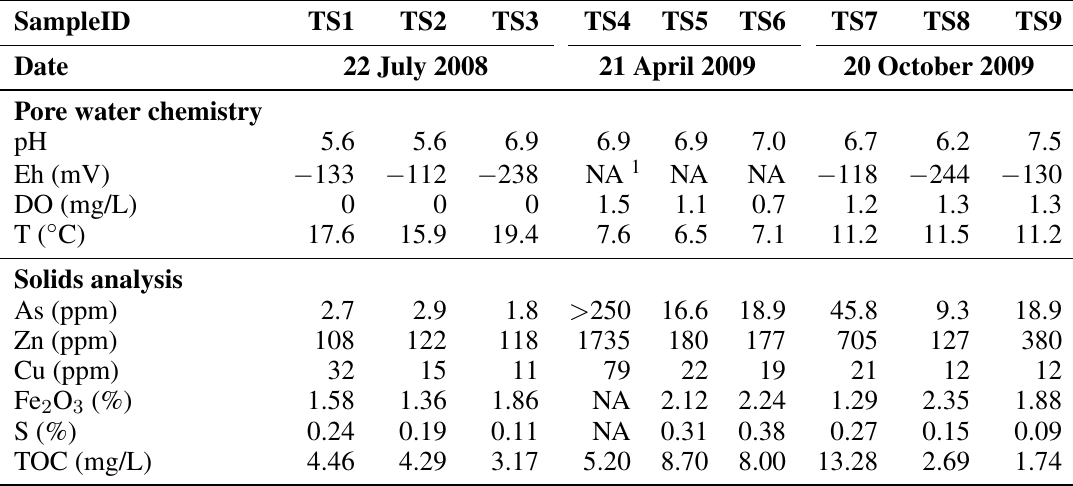
Table 1. Pore water and bulk solids chemistry measured in the core sections collected from the BCR.